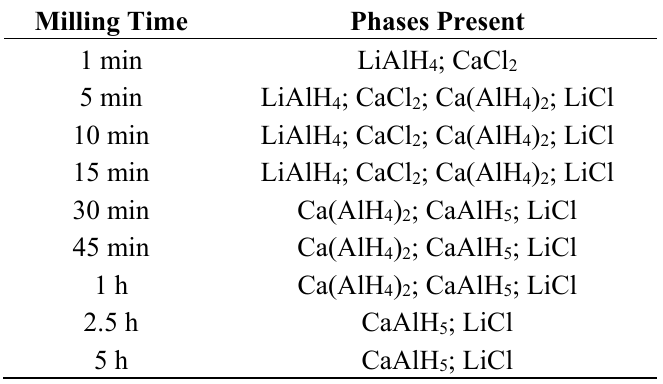
Table 1. Summary of phases present in the microstructure after various milling durations as shown in X-ray diffraction (XRD)